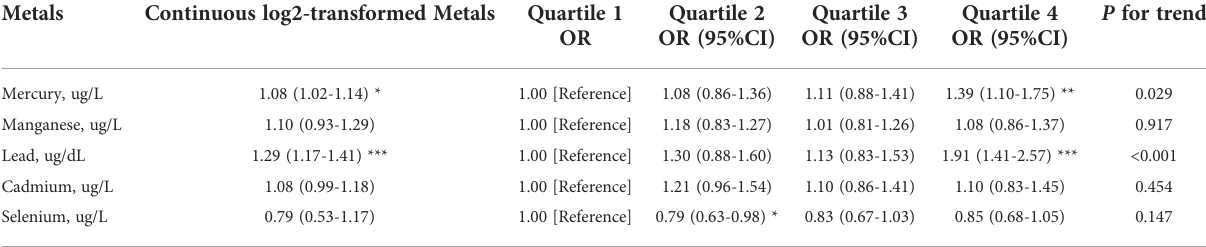
TABLE 4 Multiple logistic regression associations of blood metal levels with the prevalence of gout in adults.